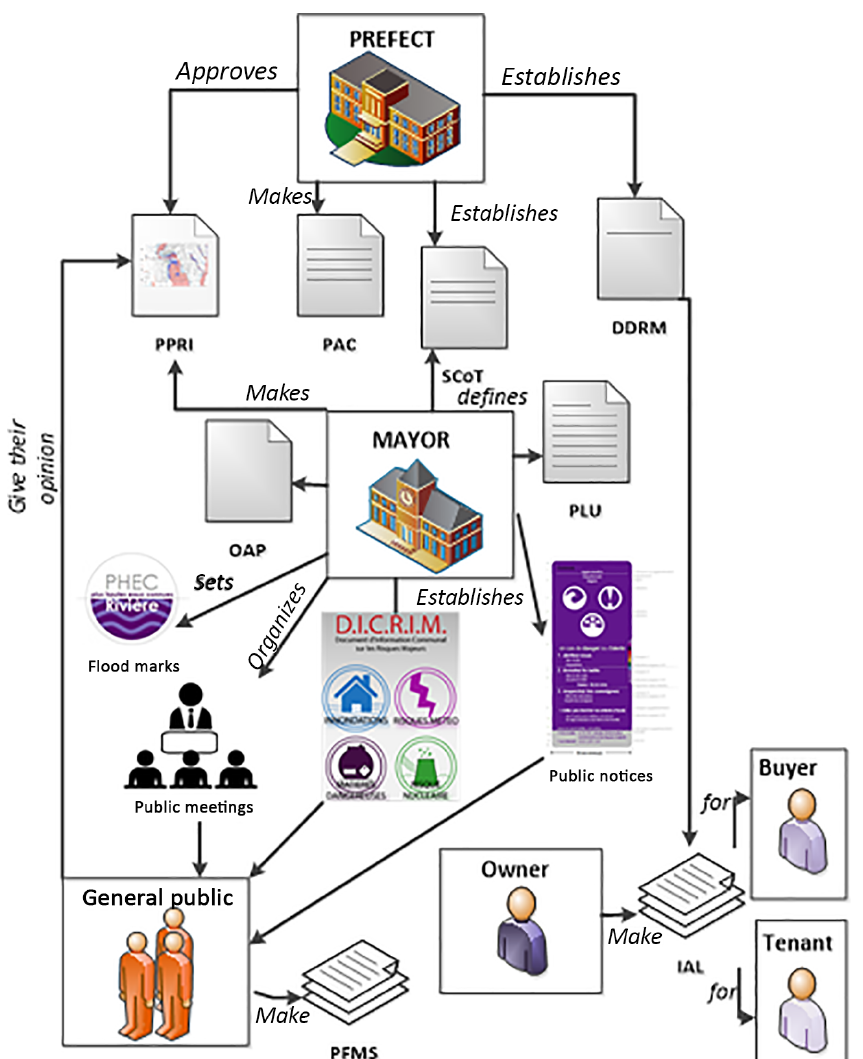
Figure 1. A prefect is a government representative of an area or department. It is thus responsible for public order, ensures the application of laws and regulations and verifies that the local authorities (town hall or EPCI, which is a grouping of town halls) respect them as well. French regulatory prevention information throughout the town include the Territorial Coherence Scheme (SCoT), Knowledge of Existing Data (PAC), Flood Risk Prevention Plan (PPRI), Development and Planning Guidelines (OAP), Local Urban Plan (PLU), Departmental Document on Major Risks (DDRM), Municipal Information Document on Major Risks (DICRIM), public notices, Purchaser Tenant Information (IAL), Family Plan for Safety Layout (PFMS), public meetings,